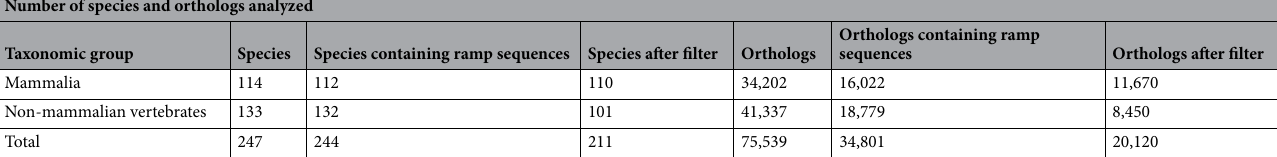
Table 1. The number of species and orthologs for each of the taxonomic groups are reported for the number of reference genomes contained in the NCBI database, the number that contained ramp sequences, and the number that passed the 5% filter